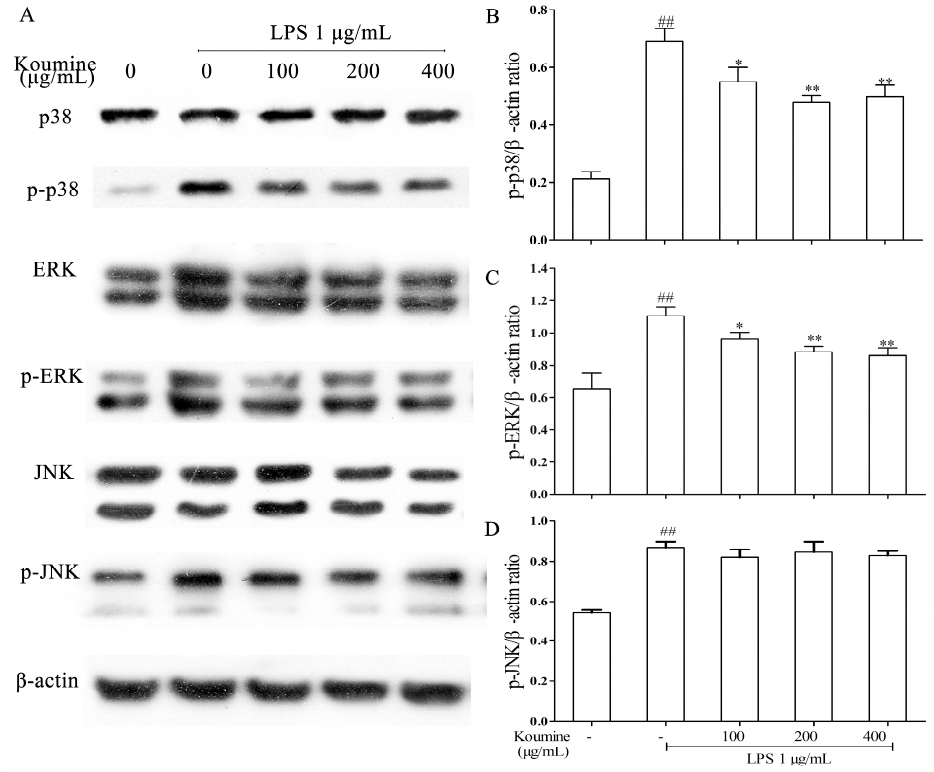
Figure 3. Effect of koumine on the expression of MAPK signaling pathway in LPS-stimulated RAW264.7 cells. Cells were pretreated with 100, 200 or 400 μ g/mL koumine for 1 h, and treated